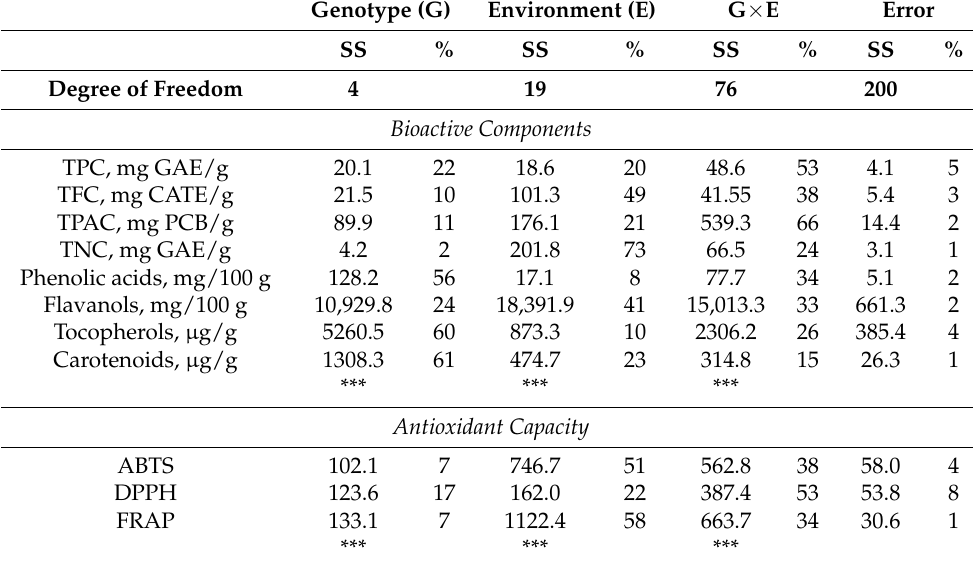
Table 3. Mean squares (SS) and percentage of the sum of the squares (%) for phytochemical com- ponents and antioxidant capacity (determined by DPPH, ABTS and FRAP methods) of five lentil genotypes evaluated across twenty environments (ten locations for two consecutive years) in